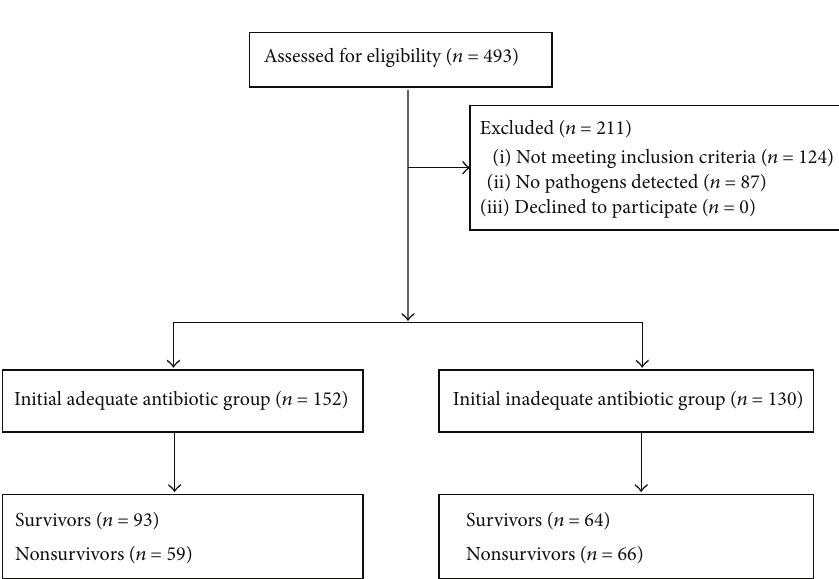
Figure 1: During the study period, 493 patients with severe sepsis and septic shock were screened, and 211 patients were excluded. The reasons for exclusion included nonpneumonia infection and no detectable pathogens in lower respiratory tract sample for culture. A total of 282 patients were enrolled for analysis. No patients withdrew. Initially, 152 and 130 patients received adequate and inadequate antibiotic therapy, respectively. Fifty-nine and 66 patients died in adequate and inadequate antibiotic groups,